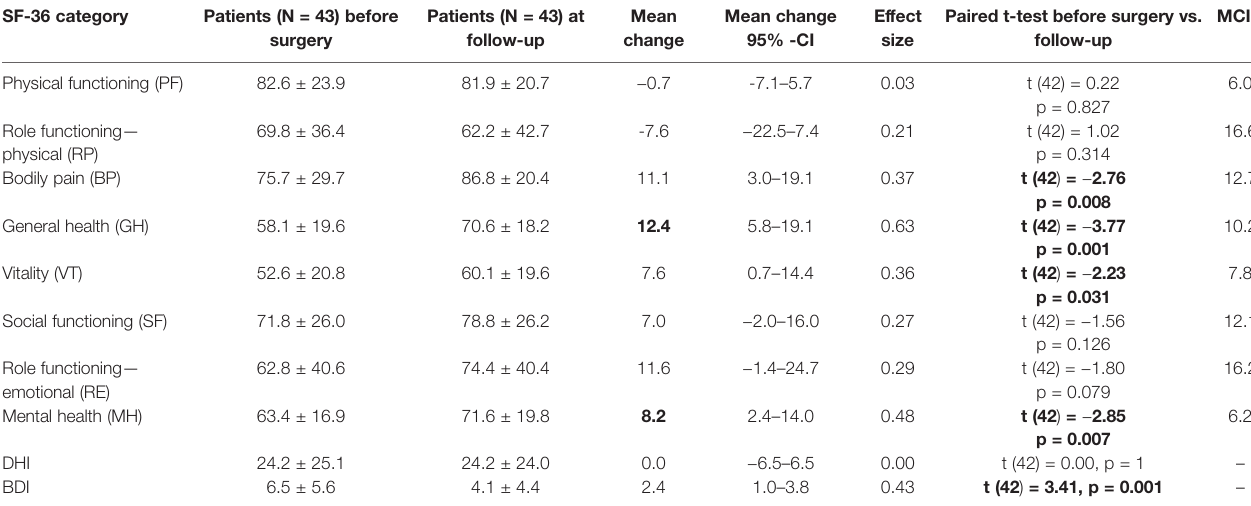
TABLE 2 | Post- vs. pre-comparison of